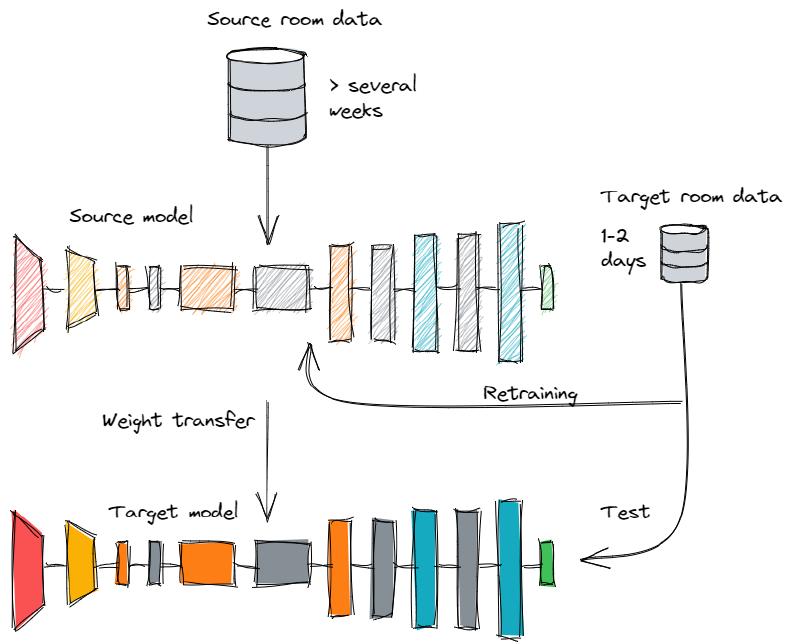
Figure 3. Diagram of proposed transfer learning